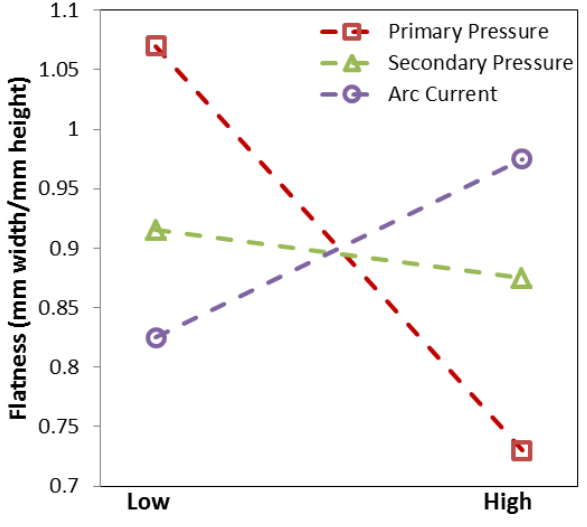
Figure 7. Effect of primary gas pressure, secondary gas pressure, and arc current on pattern flatness. A flat pattern has a high flatness. Dashed lines not meant to imply a linear